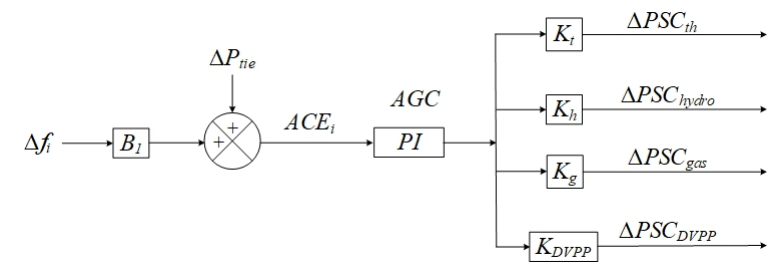
Figure 5. Direct participation of DVPPs in